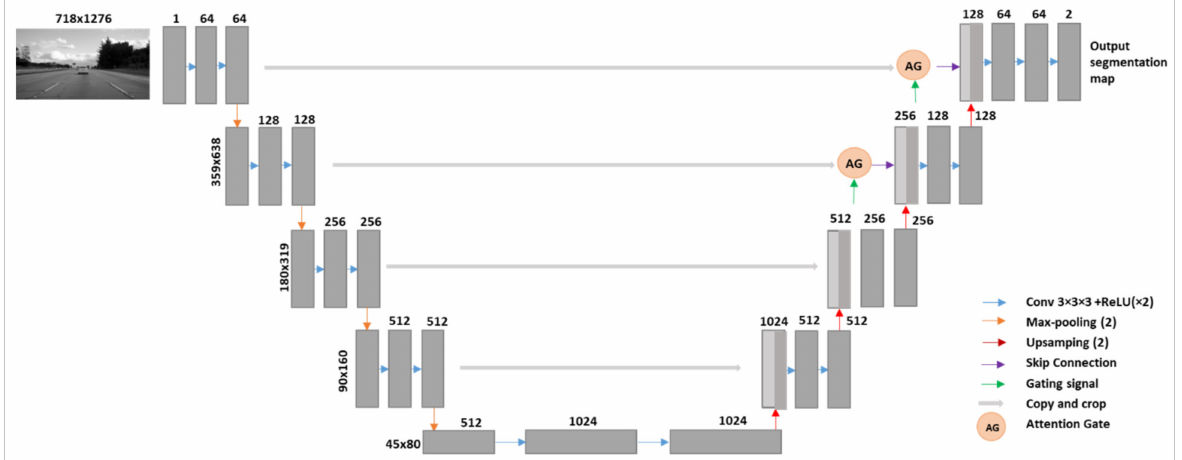
Figure 1. A block diagram of the genertor of our proposed ICGA model.